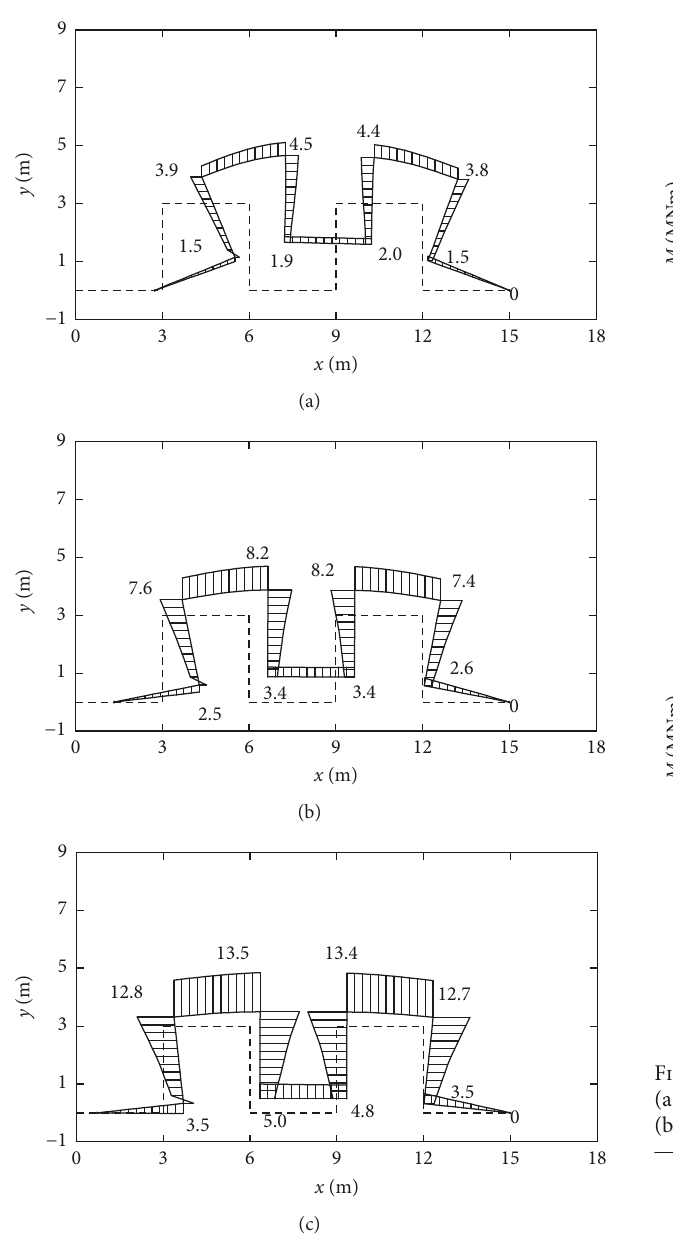
Figure 8: Maximum bending moment diagrams of the structures during impact and deflections of the structures after impact corre- sponding to different beam cross-section dimensions (unit: MNm).